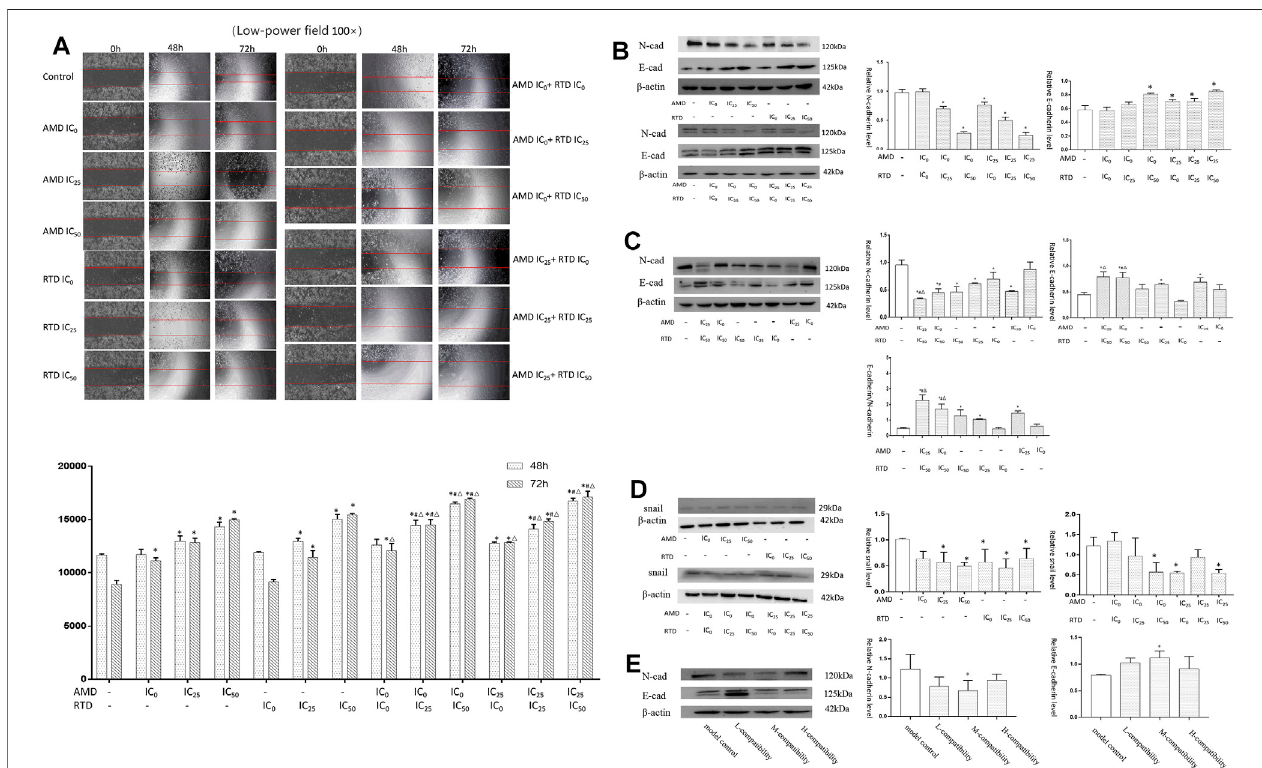
FIGURE 7 | AMD, RTD, and their compatibility inhibited MM migration. (A) Effects on A375 cell migration with AMD, RTD, and their compatibility for 48 and 72 h. (B – C) Westernblottinganalysisandrelativequanti fi cationlevelsofN-cadherinandE-cadherinexpressionofA375cellswithherbtreatmentfor48 h (B) and72 h (C) . (D) Western blotting analysis and relative quanti fi cation levels of snail expression of A375 cells with herb treatment for 48 h. n = 3. p p < 0.05, compared with the control group. # p < 0.05, compared with the corresponding AMD group. △ p < 0.05, compared with the corresponding RTD group. (E) Western blot analysis and relative quanti fi cation levels of N-cadherin and E-cadherin expression of the mice tumors. p p < 0.05, compared with MCG.